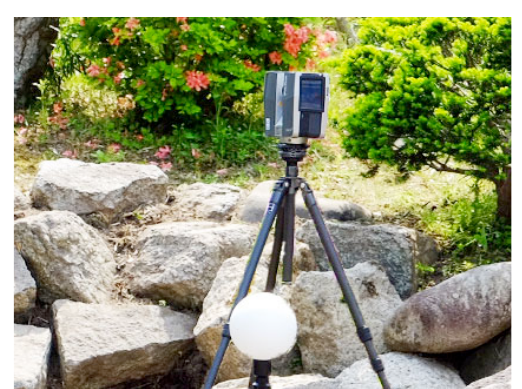
Figure 6. Measuring remains